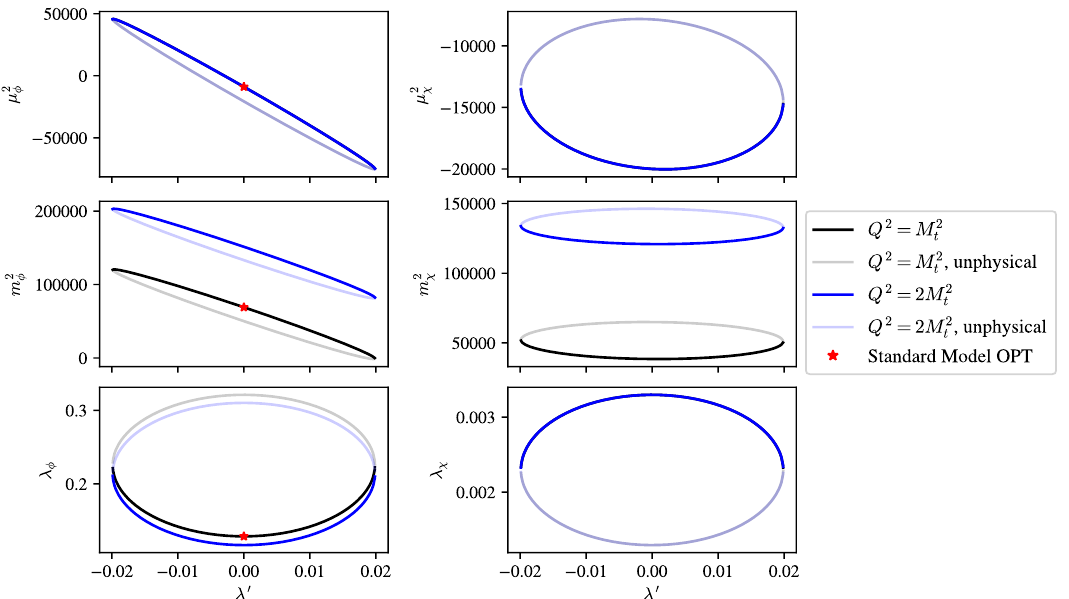
Figure 5 . Comparison of parametrizations of the singlet extended SM with w 0 = 10 v 0 and M s = 200 GeV for two values of the regularization scale Q . Larger regularization scale leads to larger values of the m 2 parameters. Positivity of m 2 is required for a fully real effective potential, and larger Q can accommodate heavier scalar masses M s as given by the bound eq.